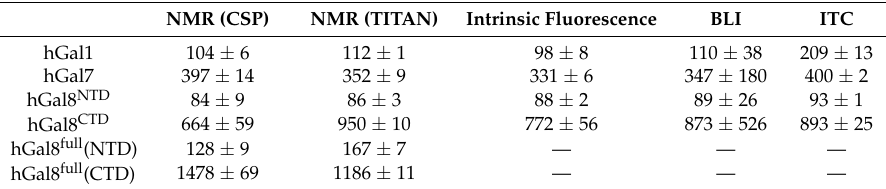
Table 1. Lactose K d of hGal1, hGal7, hGal8 NTD , hGal8 CTD , NTD of full-length galectin-8 (hGal8 full (NTD)) and CTD of full-length galectin-8 (hGal8 full (CTD)) determined by four independent biophysical tools expressed in µ M.